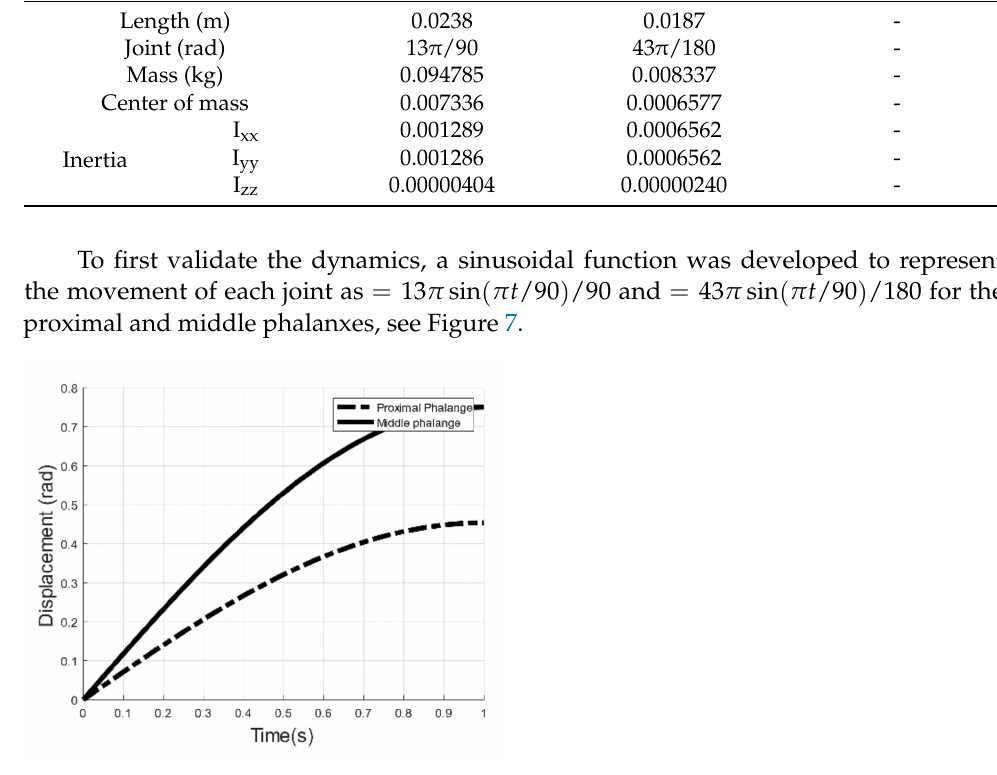
Figure 7. Proximal and media phalanges displacement.